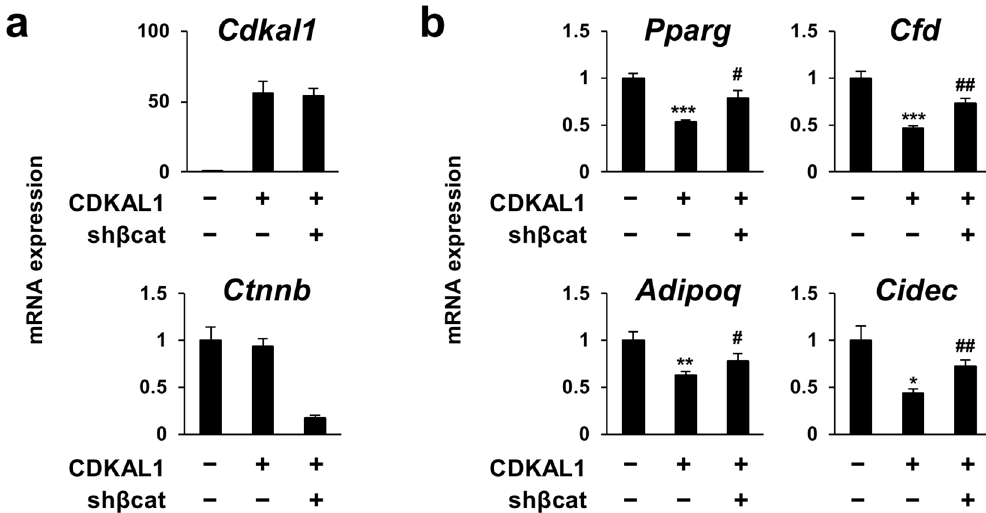
Figure 5. Knockdown of β -catenin compromised the suppression of expression of adipogenic genes by CDKAL1. Gene expression levels of ( a ) CDKAL1 and β -catenin ( Ctnnb ) and ( b ) adipogenic marker genes in 3T3-L1 adipocytes coexpressing CDKAL1 and shRNA targeting β -catenin (n = 3, * p < 0.05, ** p < 0.01, *** p < 0.001 vs control group by Student’s t-test; # p < 0.05, ## p < 0.01 vs CDKAL1 group by Student’s